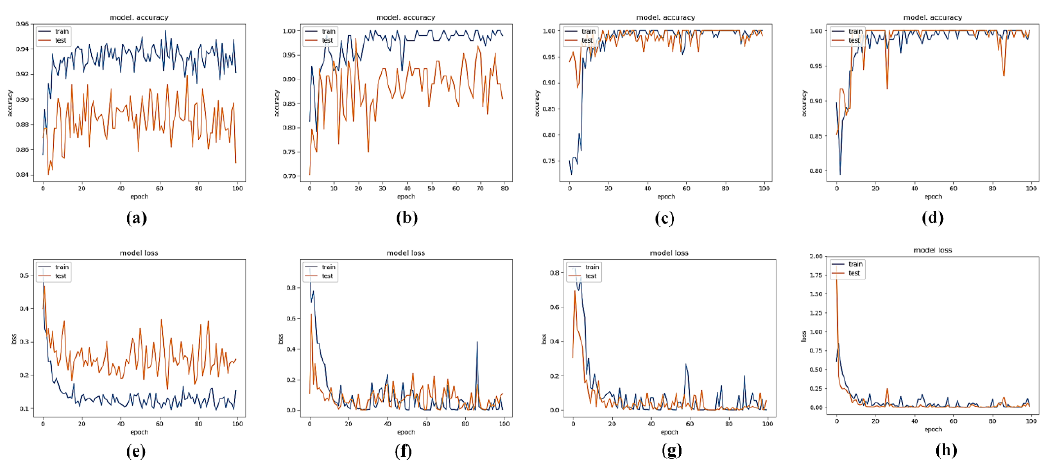
Figure 7. Performance results for di ff erent time windows, the accuracy results for the 1 s, 2 s, 3 s, and 4 s time windows are shown in ( a – d ), respectively. The corresponding training losses are shown in ( e – h ).